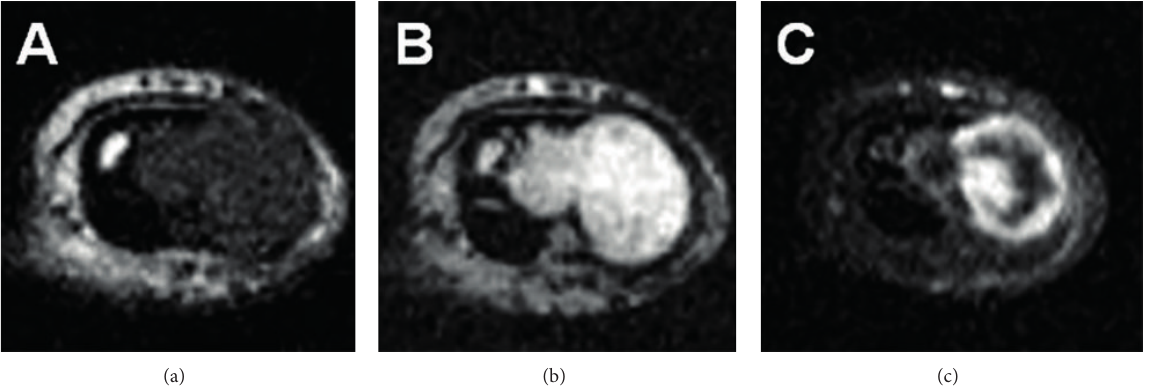
Figure 4: Axial magnetic resonance imaging showing a well-defined juxtacortical mass with intermediate signal intensity on T1-weighted image (a) and high signal intensity on T2-weighted image (b). Contrast-enhanced fat-suppressed T1-weighted image (c) demonstrates peripheral and septal enhancement.